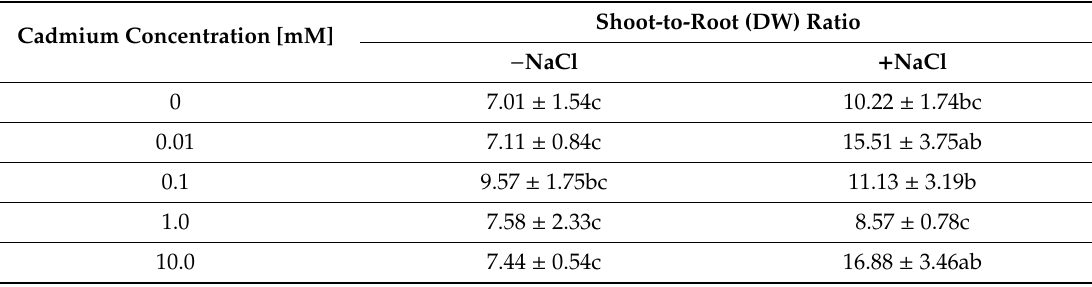
Table 3. Shoot-to-root dry weight (DW) ratio in soil-grown NaCl-untreated ( − NaCl) and salt-stressed ( + NaCl) M. crystallinum plants subjected to elevated Cd concentrations and